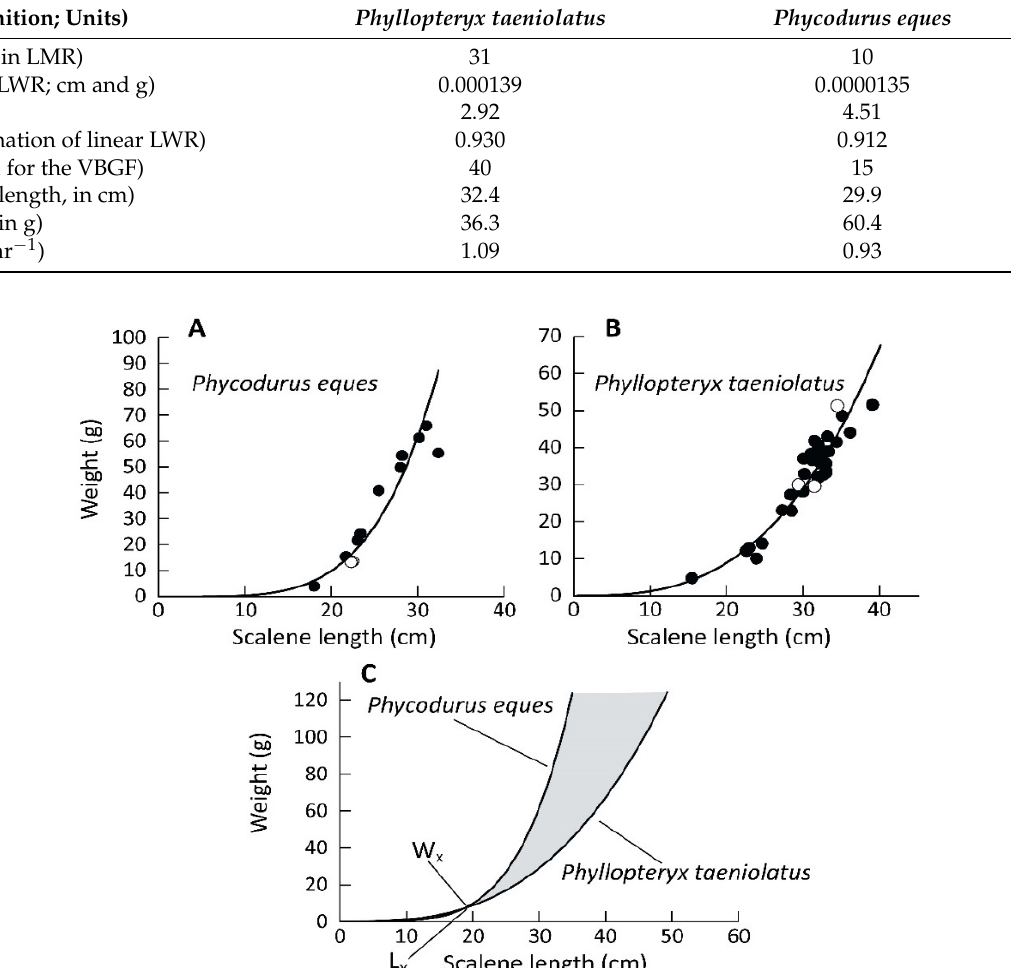
Figure 3. Length–weight relationships (LWR) of the common ( A ) and leafy ( B ) seadragons of both sexes (see also Table 3). The open dots refer to non-intact specimens (see Tables 1 and 2), which were not used in computing the LWR. Panel ( C ) shows where the two LWR cross and highlights (in grey) the weight-at-length difference between the two species.